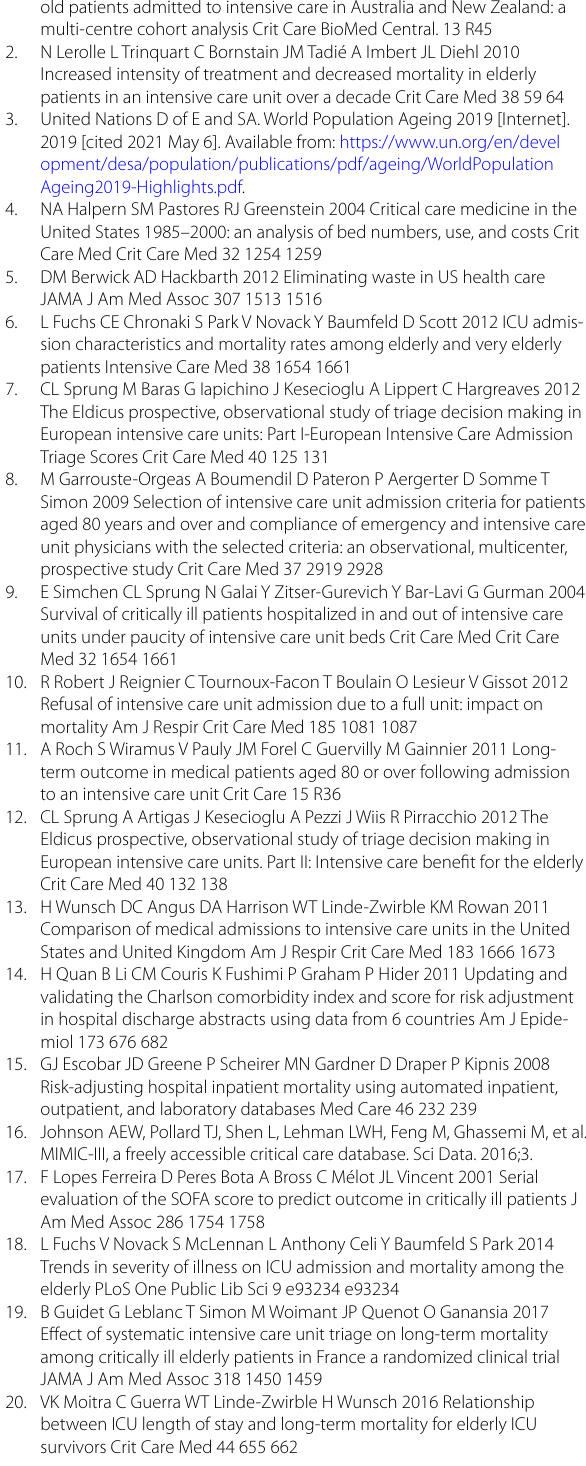
Additional file 1: Table S1. Characteristics of the 5th quintile from Table 3. Table S2. Characteristics of The Patients at First Admission,